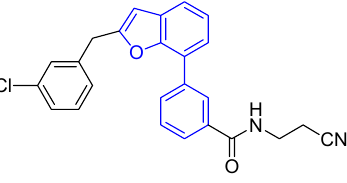
Figure 1. 7-Aryl benzofuran structure core in different bioactive